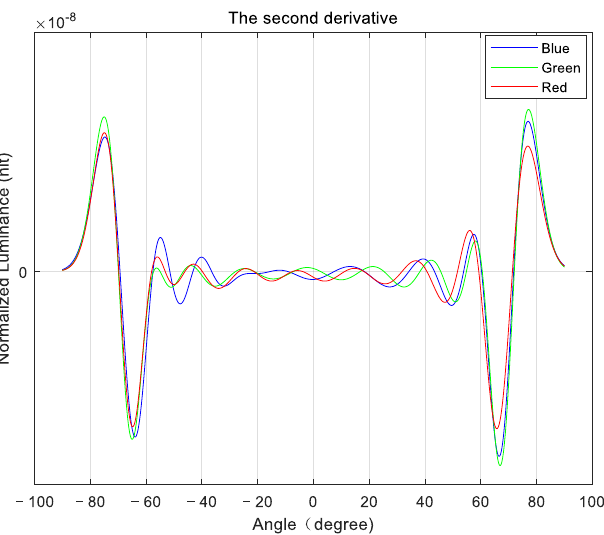
Figure 5. The second derivative of the luminance attenuation fitting curve.